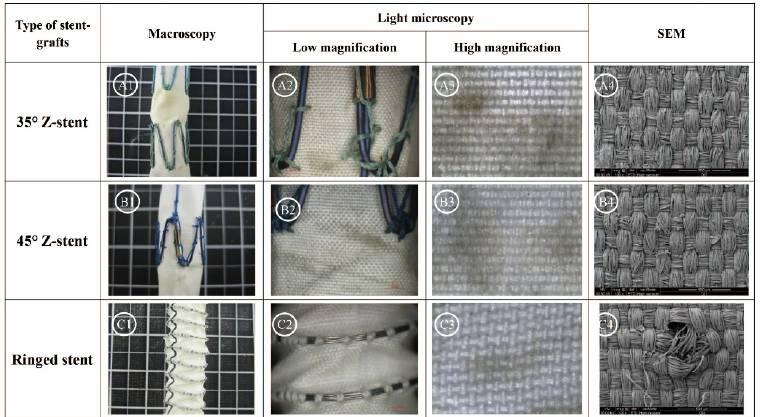
Figure 6. Twist simulations for 48 h. The fabrics of the stent ‐ grafts supported by Z ‐ stents were more severely abraded than the fabric of the ringed stent ‐ graft. Broken sutures are found in the 35° Z ‐ stents. The SEM confirms the best resistance to fabric abrasion by the ringed stent ‐ grafts, and the enlarged suture holes in this device ( C4 ). ( A1 , B1 , C1 ) Gross observations; ( A2 , B2 , C2 ) Observation in light microscopy with low magnification (10×); ( A3 , B3 , C3 ) Observation in light microscopy with high magnification (40×); ( A4 , B4 , C4 ) Observation in SEM (100×).